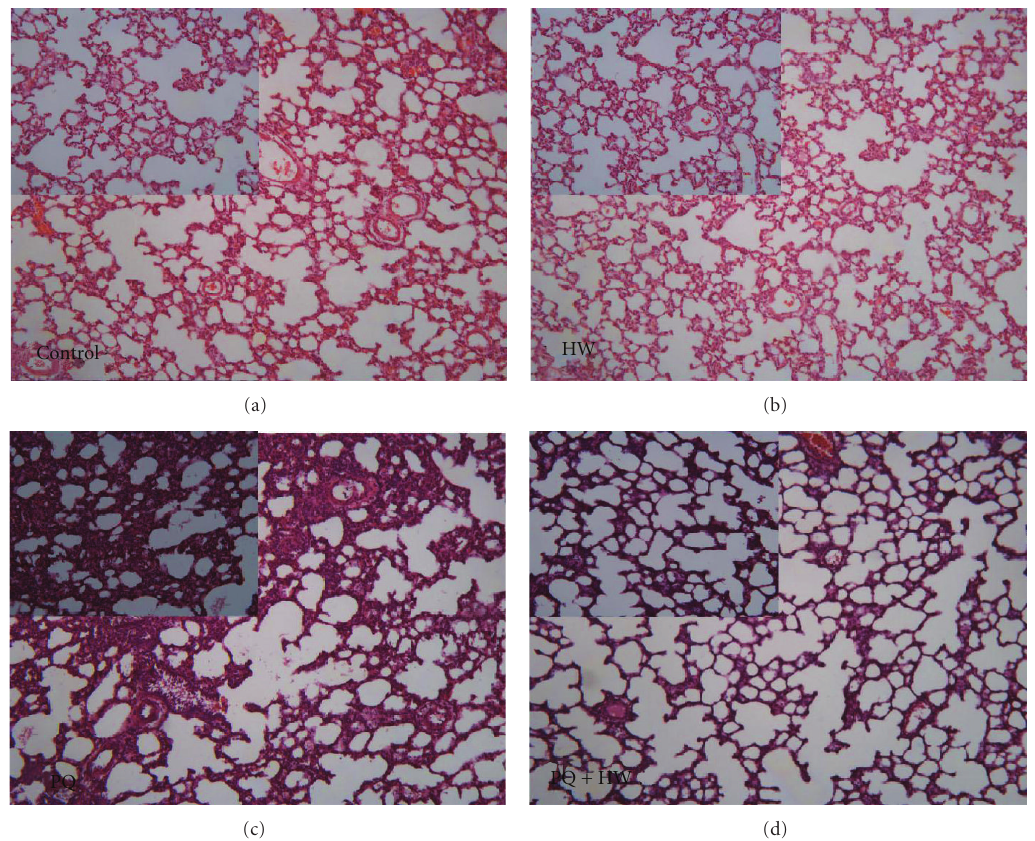
Figure 4: Histopathological examination by H&E staining. Striking di ff erences were observed in lung histology between the two experimental groups. Marked lung hemorrhage, edema, alveolar septal thickening, influx of inflammatory cells, and fibrin deposition were observed in rats injected with paraquat alone. In contrast, in PQ + HW group, the lung damage was alleviated, suggesting hydrogen water protected paraquat-induced acute lung